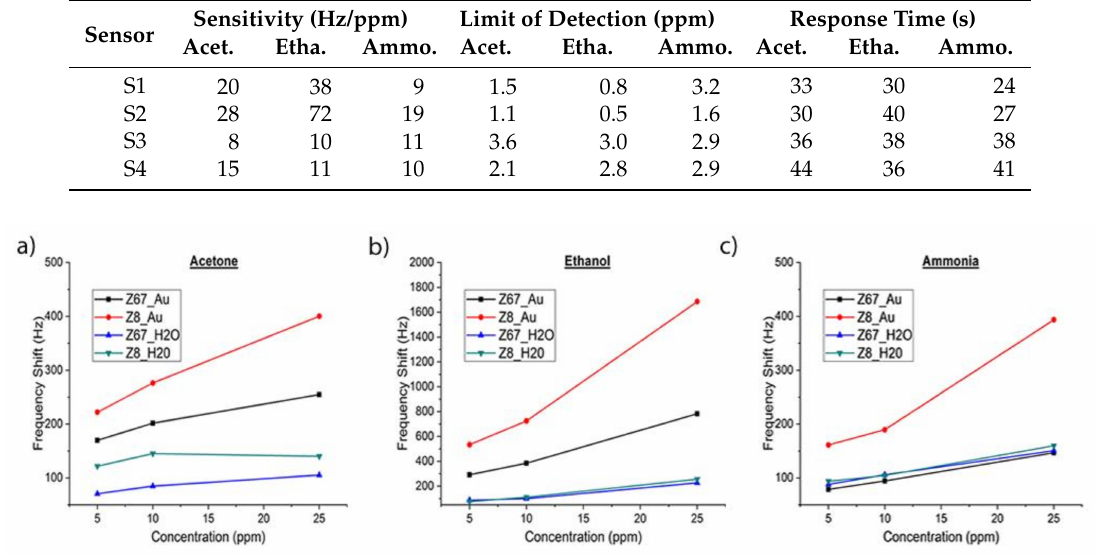
Figure 9. Calibration curves of the sensors S1, S2, S3 and S4 for ( a ) acetone, ( b ) ethanol and ( c )